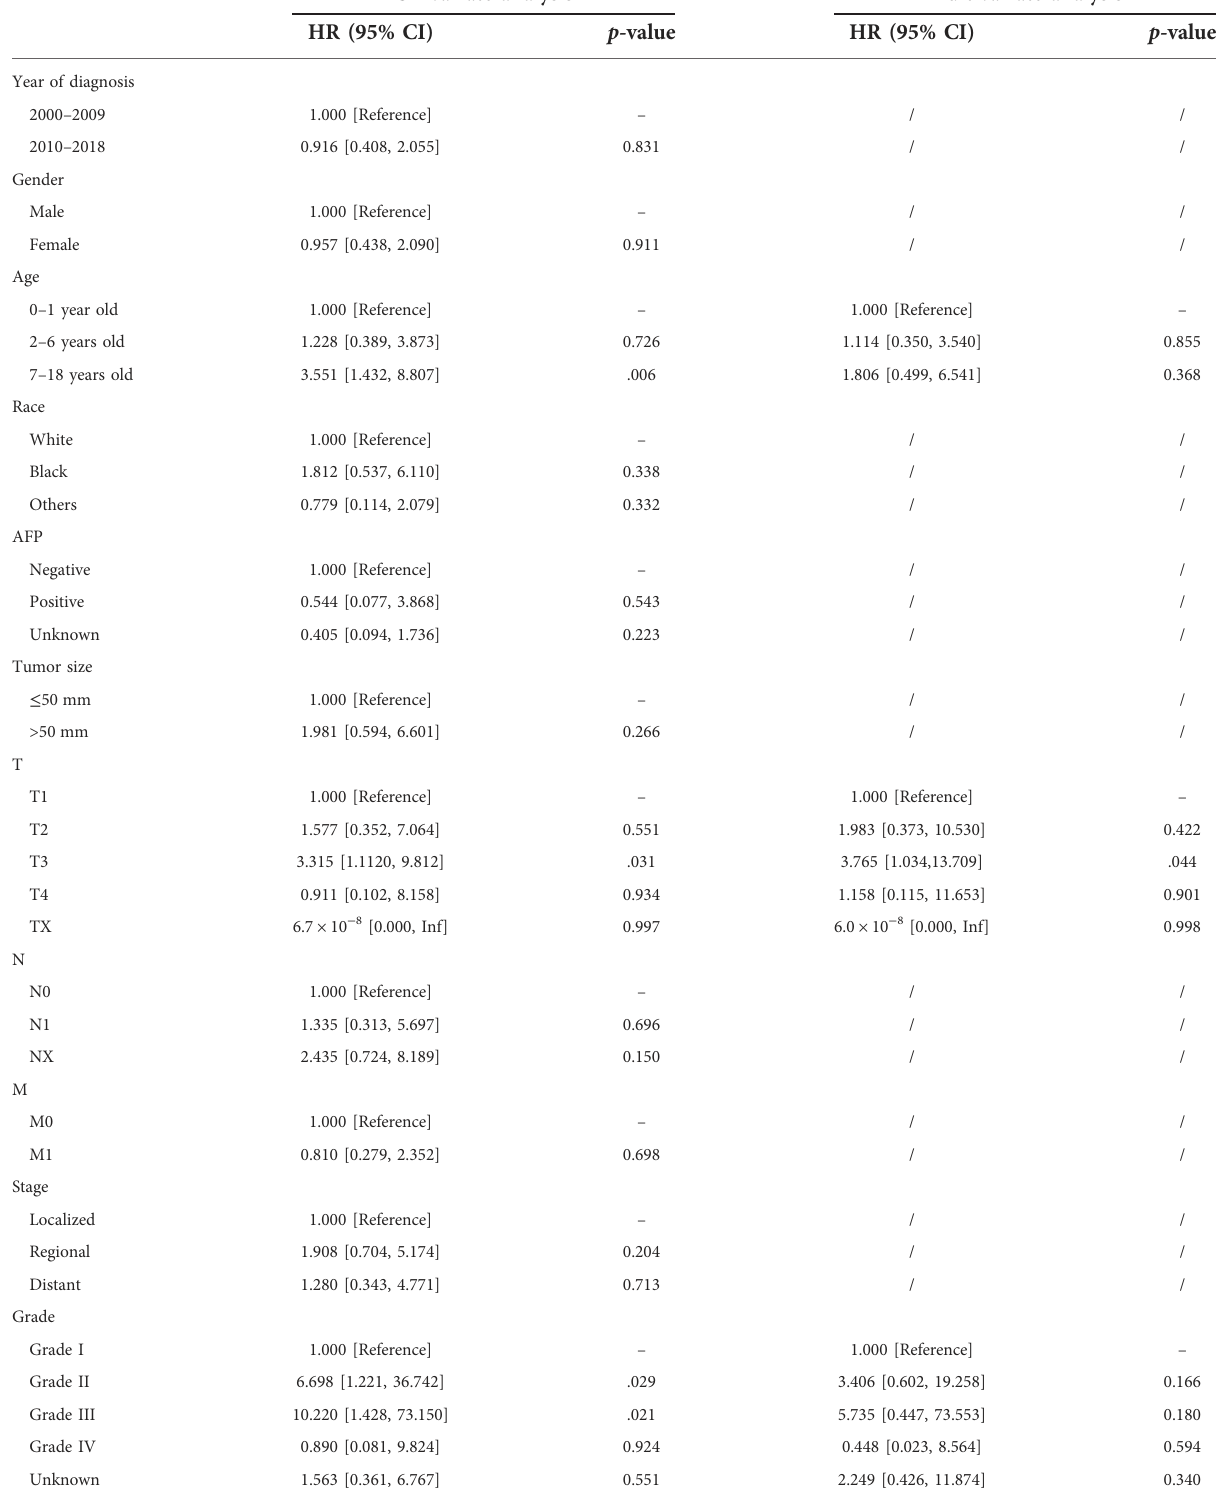
TABLE 2 Univariate and multivariate regression analysis in the LT